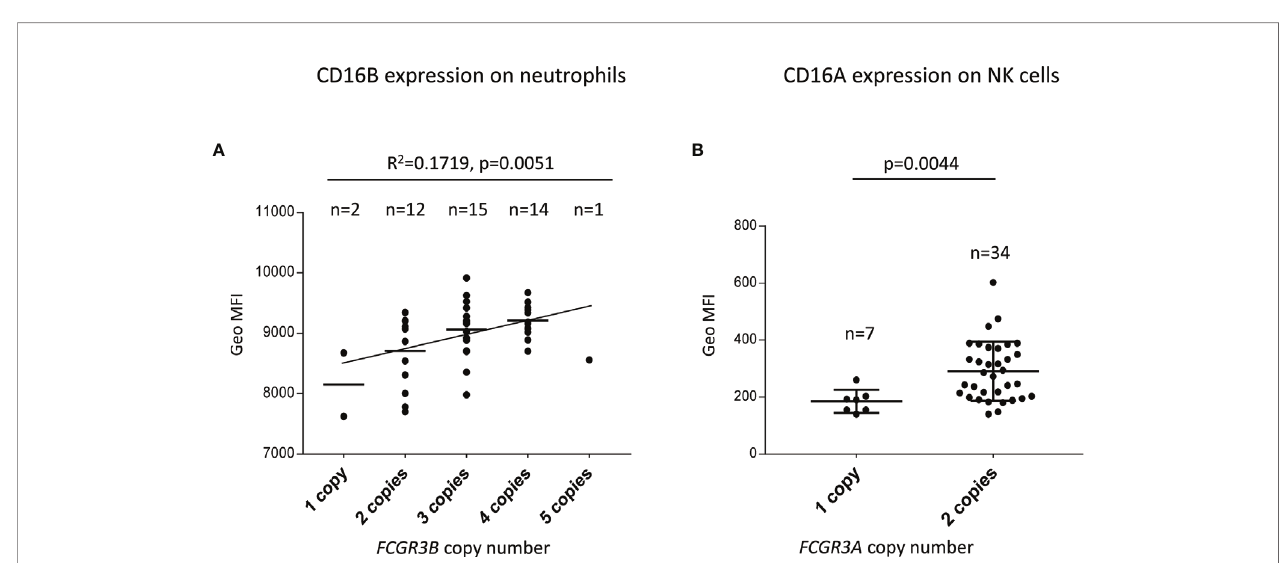
FIGURE 5 | FCGR3B and FCGR3A copy-number modi fi es receptor expression. (A) A linear regression test predicts a direct correlation between FCGR3B copy number and CD16B surface expression on granulocytes. Additional tests were performed to con fi rm that the relationship between predictor and outcome is linear, the error variance is constant and the errors are normally distributed and independent. (B) FCGR3A two-copy carriers express signi fi cantly more CD16A on NK cells than hemizygotes (a Mann-Whitney non parametric test was used to compare CD16A MFI on NK cells between the two